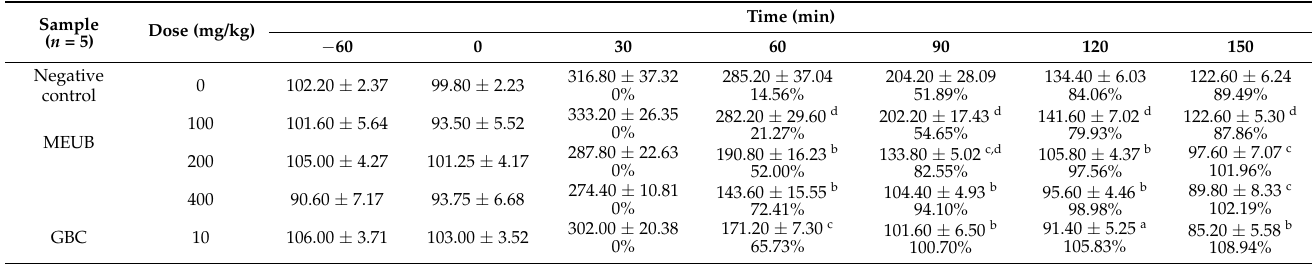
Table 6. Effect of MEUB and GBC on blood glucose level in mice